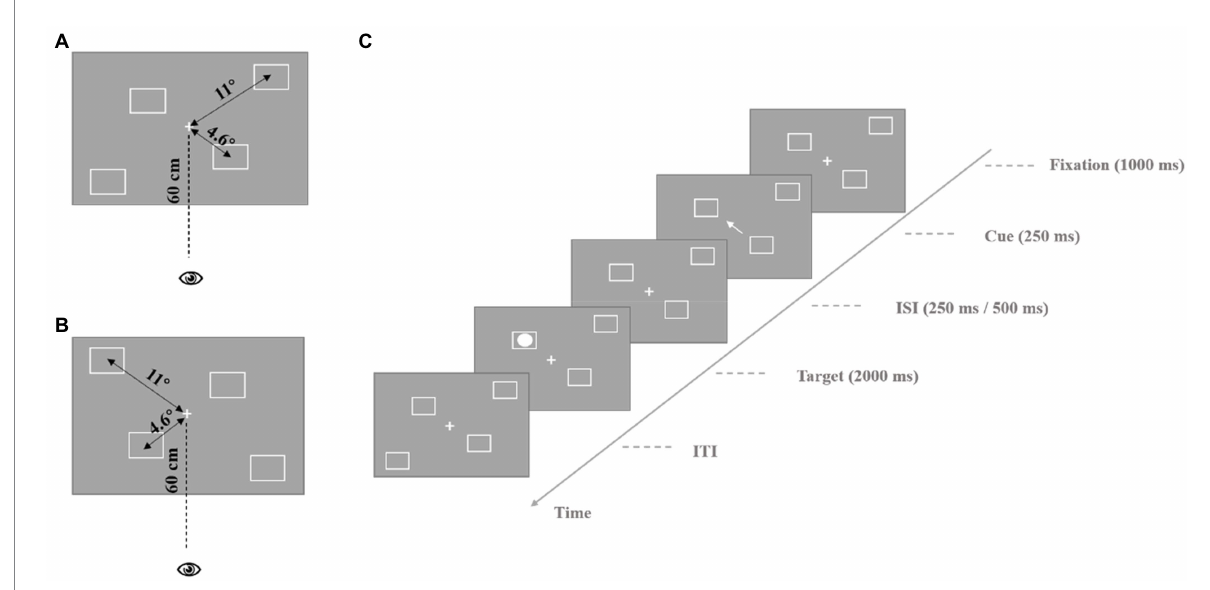
FIGURE 1 Process of endogenous cue experiment. (A) The stimulus parameters are presented in the experiment. The central location stimulus is presented at the participant’s 4.6 ° visual angle, the peripheral location stimulus is presented at the participant’s 11 ° visual angle, participant’s eyes are 60 cm away from the screen. (B) Different spatial distribution type of squares. The parameters of stimulus are the same as (A) . (C) The process of a single trail. ISI, inter-stimulus interval; ITI, inter-trial